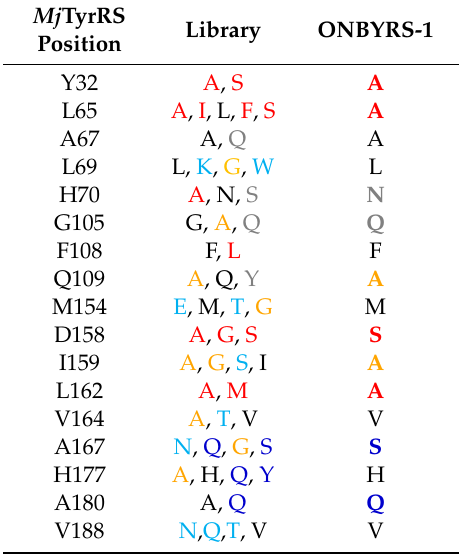
Wild type aaRS residues depicted in black. Mutations are classified according to the following color code: first-shell mutations: space / packing around substrate (red), polar interactions with ONB nitro group (blue); second-shell mutations: space / packing around first-shell mutations (orange), polar interactions with first-shell mutations (light blue). Additional mutations beyond these classifications shown in gray. All Mj TyrRS variants used in this study bear a fixed D286R mutation to improve amber suppression e ffi ciency